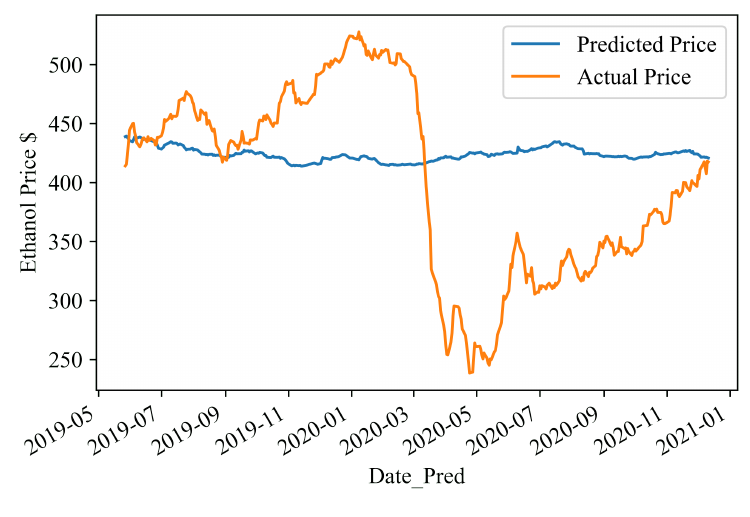
Figure 8. Predictions for 126 days ahead.